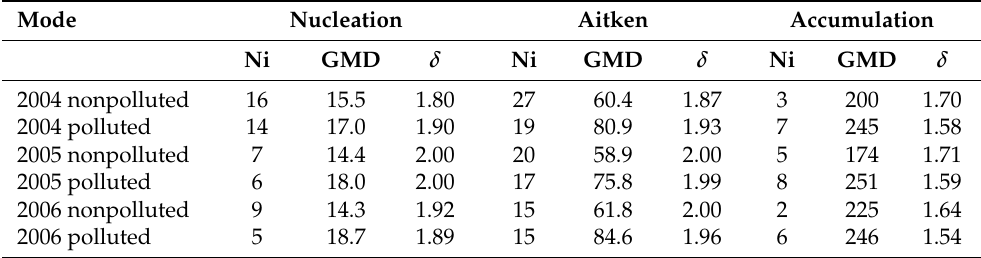
Table 1. Average lognormal fit parameters of the particle number size distributions and meteorologi- cal factors on polluted and nonpolluted days in the summers of 2004, 2005, and 2006. Mode Nucleation